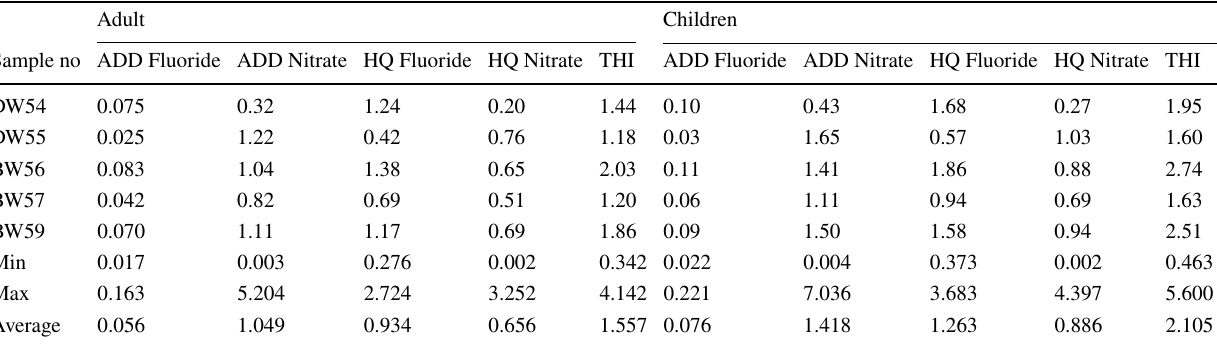
Fig. 8 a The comparison between total hazard index with Adult and children in the study region for post-monsoon season. b The comparison between total hazard index with Adult and children in the study region for pre-monsoon